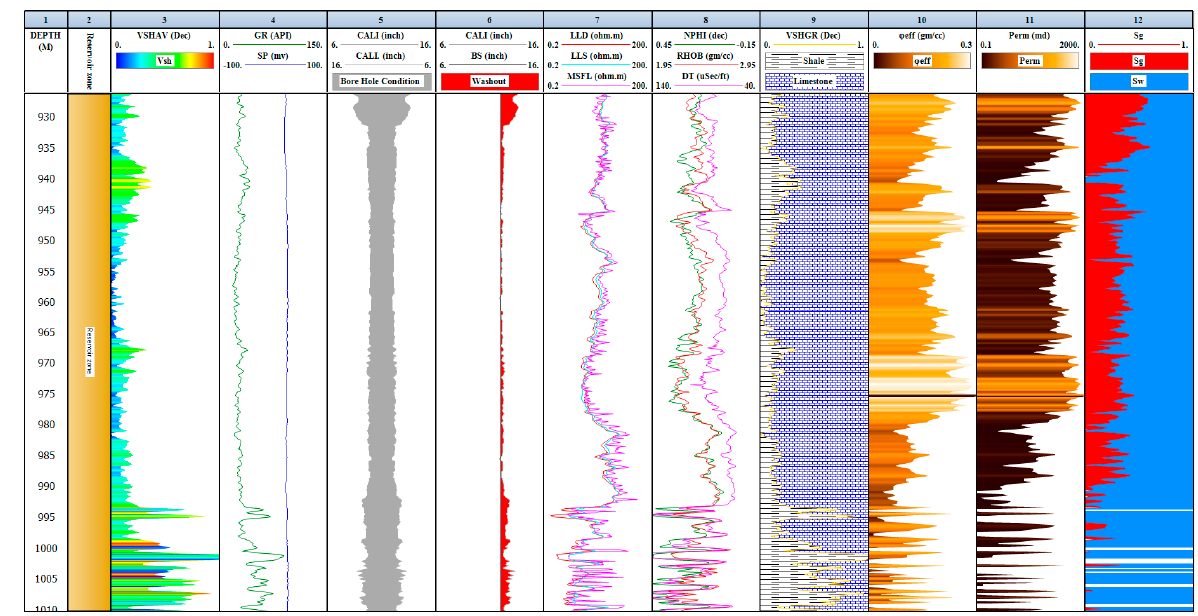
Figure 4. Lithosaturation mapping of the QGF well 03 reservoir zones within the study